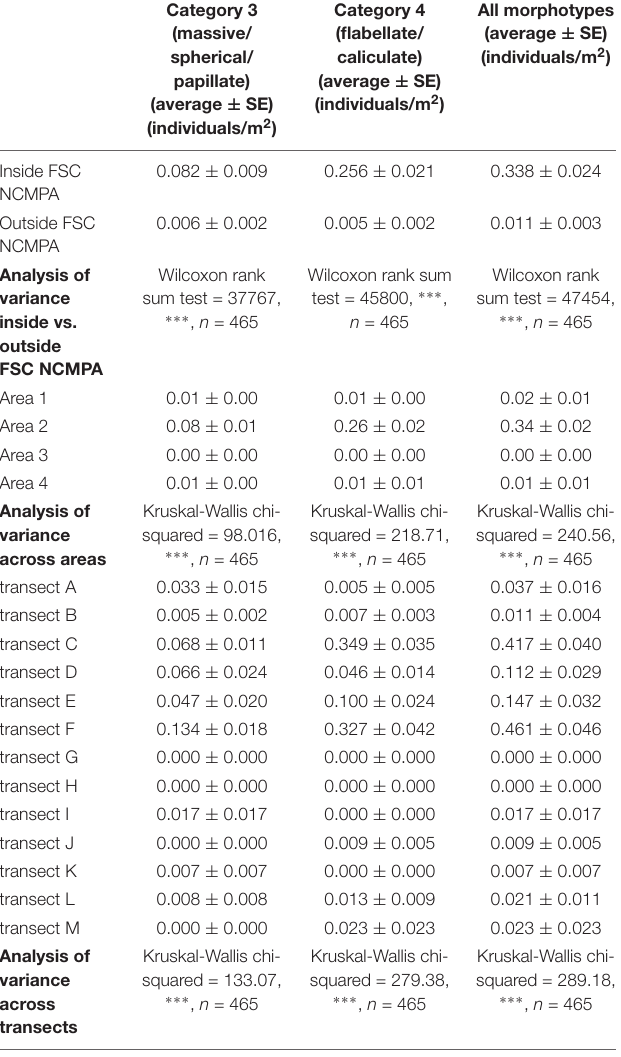
TABLE 3 | Density of Category 3 (massive/spherical/papillate) and Category 4 (flabellate/caliculate) sponges inside and outside the Faroe-Shetland Channel Nature Conservation Marine Protected Area (FSC NCMPA), across areas (Area 1, Area 2, Area 3, and Area 4) and across